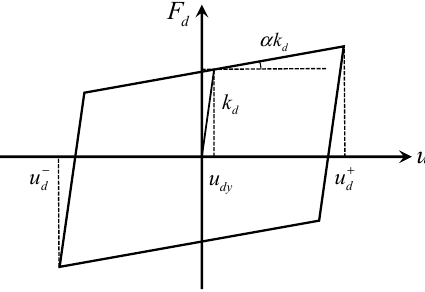
Figure 2. Hysteresis curve of the displacement-dependent damping element (DDE).